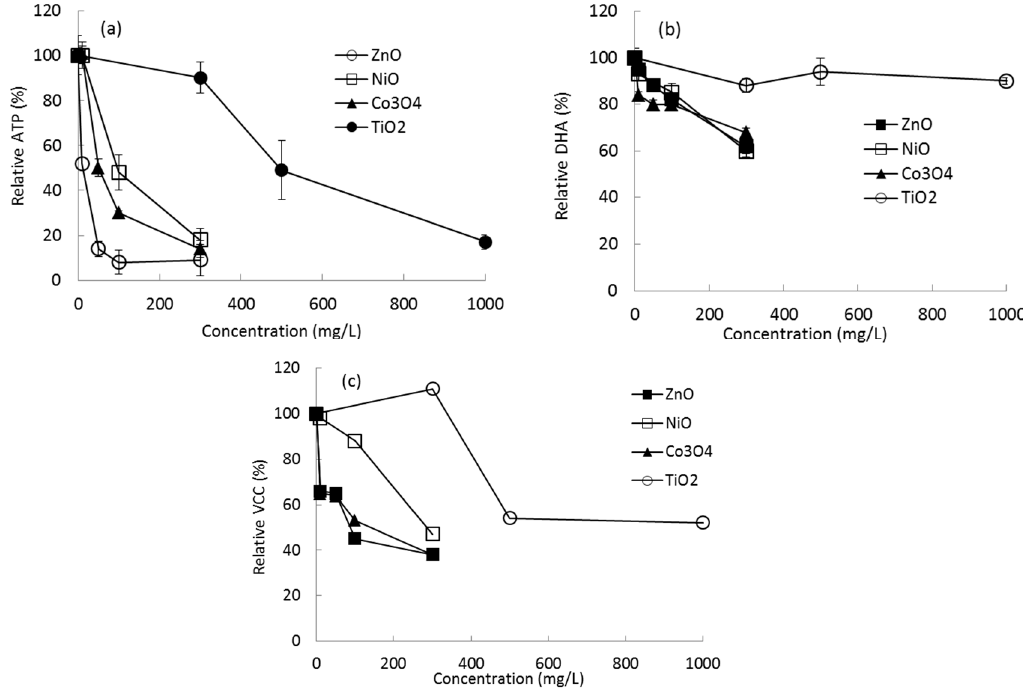
Figure 1. Effects of NPs on microbial growth on sandy soil based on relative ( a ) ATP content; ( b ) DHA; and ( c ) VCC.